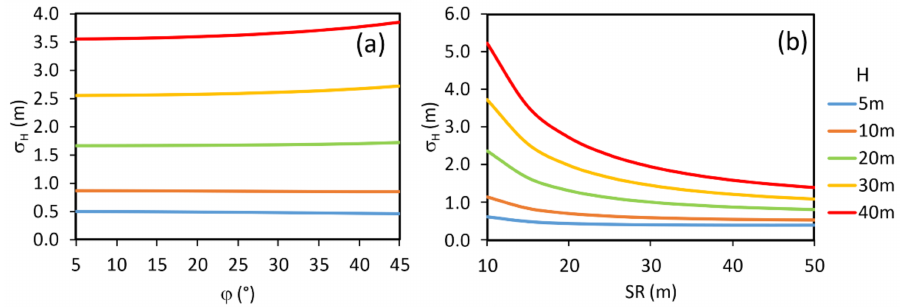
Figure 5. ( a ) σ H scenarios derived by applying VPL changing ϕ and parameterizing Equation (3) by H ; ( b ) σ H scenarios derived by applying VPL changing SR and parameterizing Equation (3) by H